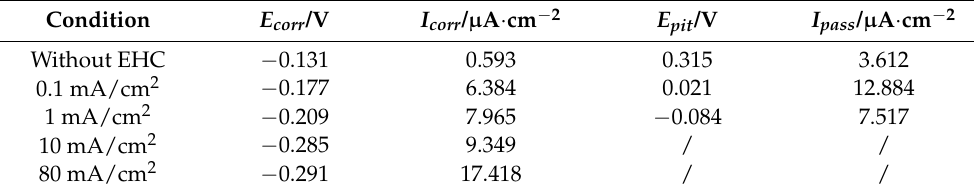
Table 4. The obtained results from polarization curve test under different conditions.